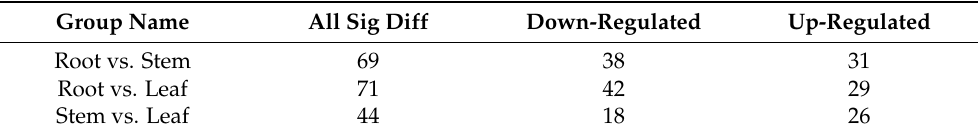
Figure 5. Cluster map of metabolites in different parts of Houttuynia cordata . The color sequence from red to blue indicates metabolites abundance from high to low. Table 1. Statistical table of the number of metabolites in different parts of Houttuynia cordata